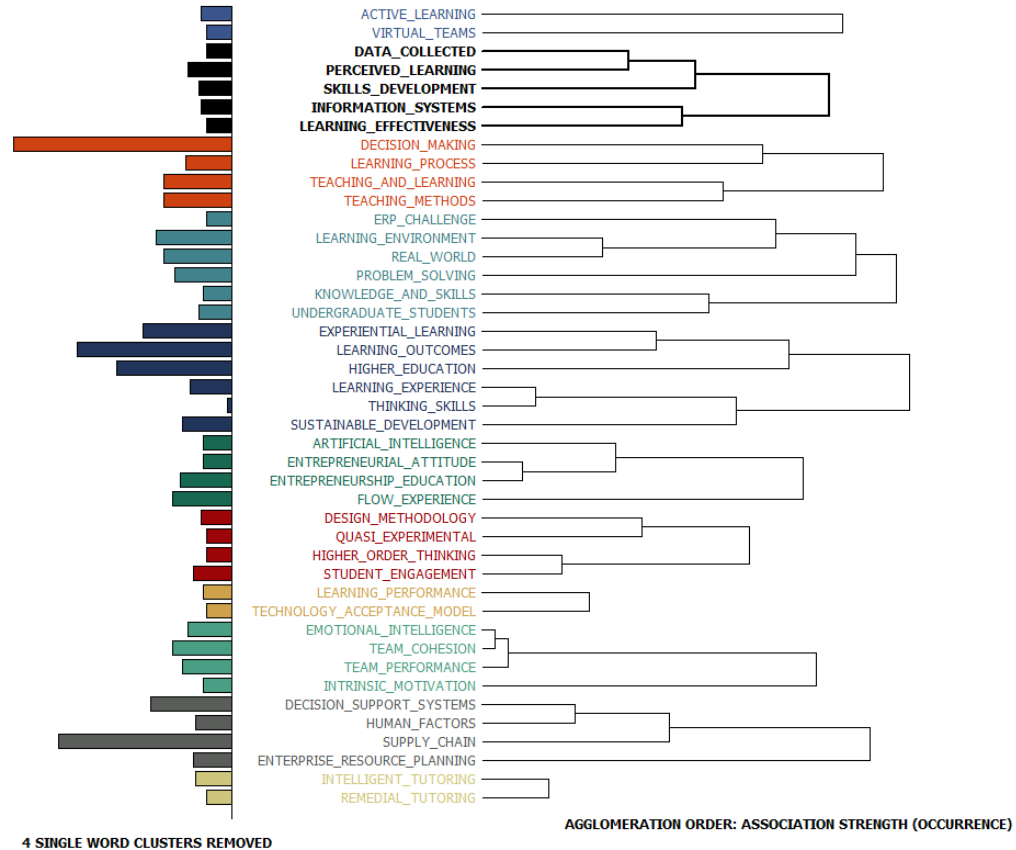
Figure 12. Cluster results of the phrases; Source: Authors’ work based on Scopus.